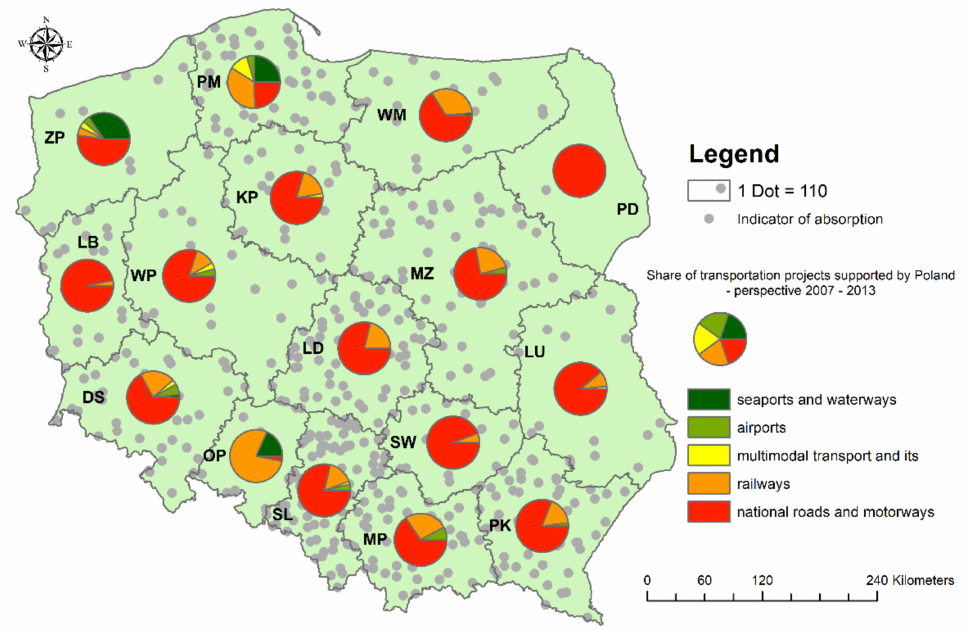
Figure 3. Expenditures on transport development in provinces with a use of Operational Program Infrastructure and Environment implemented in the financial perspective 2007–2013. Source: the authors, based on